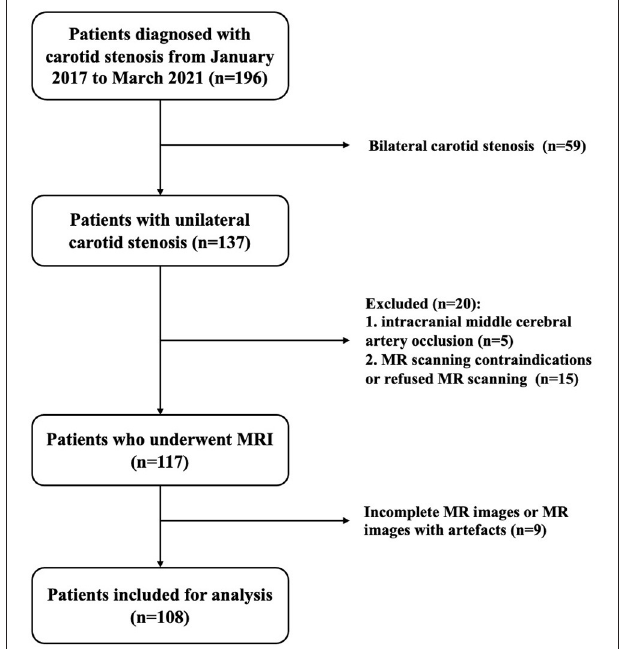
FIGURE 1 | Flowchart of patient